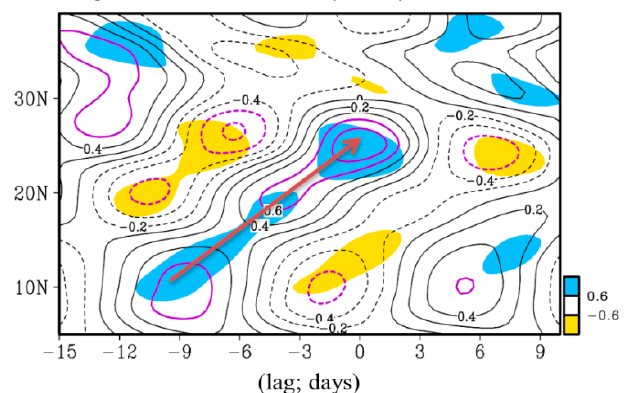
Figure 9. The shaded areas represent the time lagged correlation between the time series of the 10 to 30 day band pass filtered rainfall in Taiwan (i.e., green line in Figure 4c) and the latitude-time diagram of the 10–30 day band pass filtered rainfall averaged over (115–125° E) during May and June, 2017. Only the areas that passed the significance test are shaded. The contour areas represent the related time lagged correlation between the green line in Figure 4c and the 10 to 30 day band pass filtered vertically and integrated specific humidity averaged over 115–125° E during May and June, 2017. Only the areas passed the significance test are colored in purple. The red arrow is added to help indicate the northward propagation feature.